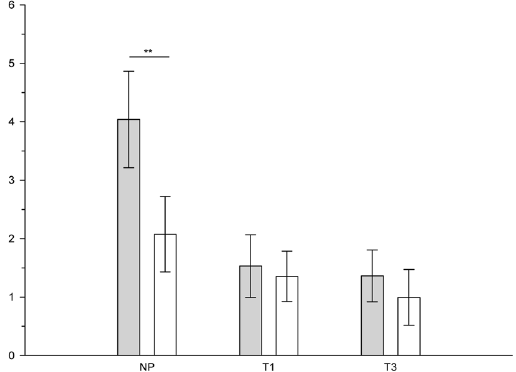
Figure 3. Mean ( ± SEM) P3-2 amplitudes ( µ V) in response to anxiety sweat (grey bars) and sport sweat (white bars) deviant stimuli of non-pregnant women (NP), pregnant women in the first (T1), and pregnant women in the third trimester (T3), ** p ≤ 0.01.